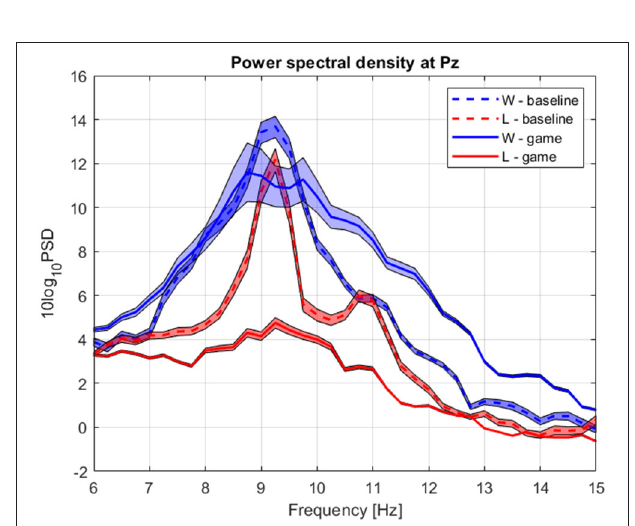
FIGURE 8 | Group average power spectrum density during baseline (dashed) and competitive gaming (continuous) for winners (blue) and losers (red). Shaded area, standard deviation of the